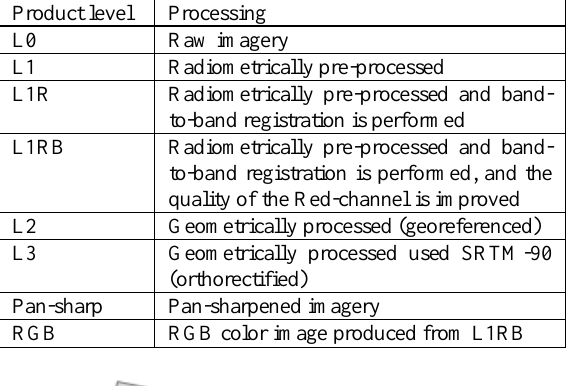
Table 2. RASAT imagery processing levels (Gezgin, 2016).